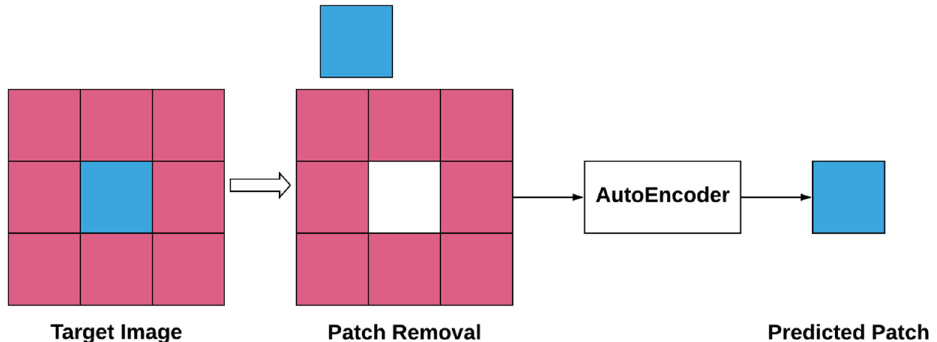
Figure 8. An illustration of the algorithm used in [52]. A patch is removed from a target image. The incomplete image is then passed to an autoencoder, which is tasked with predicting the missing section of the image.